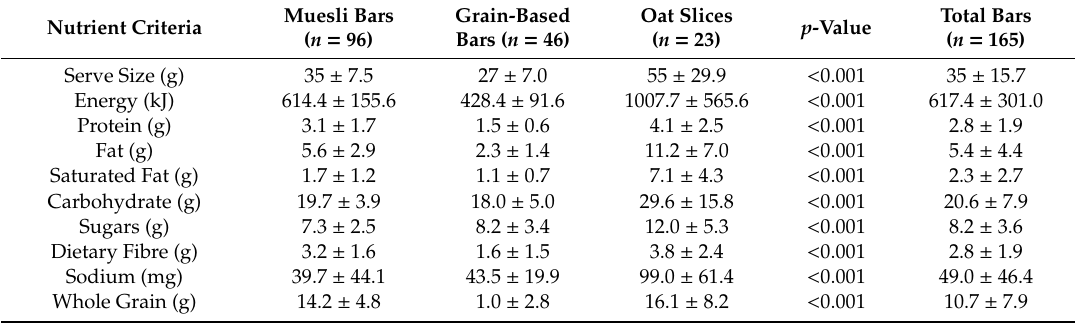
Table 2. Nutrients per serve (mean & SD): muesli bars, grain-based bars, and oat slices including whole grain.